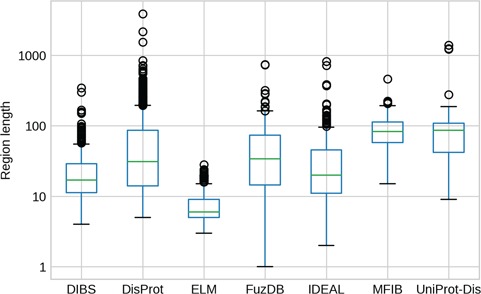
IDR length distributions. The y-axis is in logarithmic scale. Box plots of the region length distribution in each dataset. Whiskers represent the 25 and 75% of the data and outliers are shown as circles.